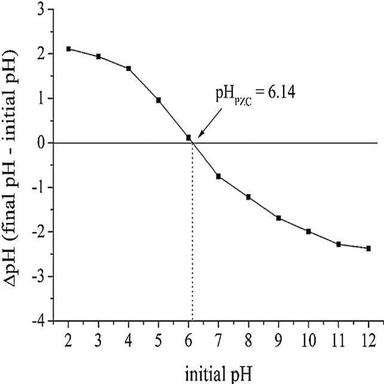
Experimental determination of pHPZC of GO-MnFe2O4/VAC.